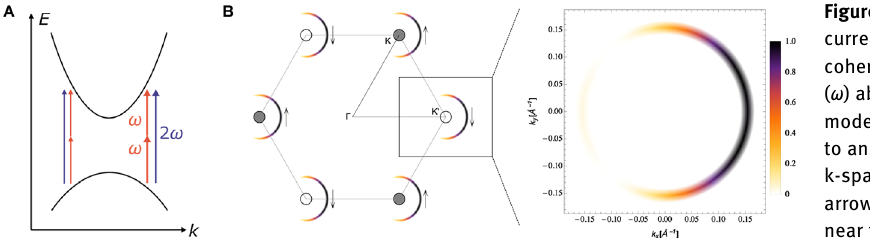
Figure 2: Coherent control of injection currents. (A) Schematic depiction of a coherent one-photon (2 ω ) and two-photon ( ω ) absorption process in a two-band model. The coherent superposition leads to an asymmetric fi nal state amplitude in k-space, as indicated by the width of the arrows. (B) Calculated carrier distribution near the K and K ′ valleys of WSe 2 for a coherent one- and two-photon